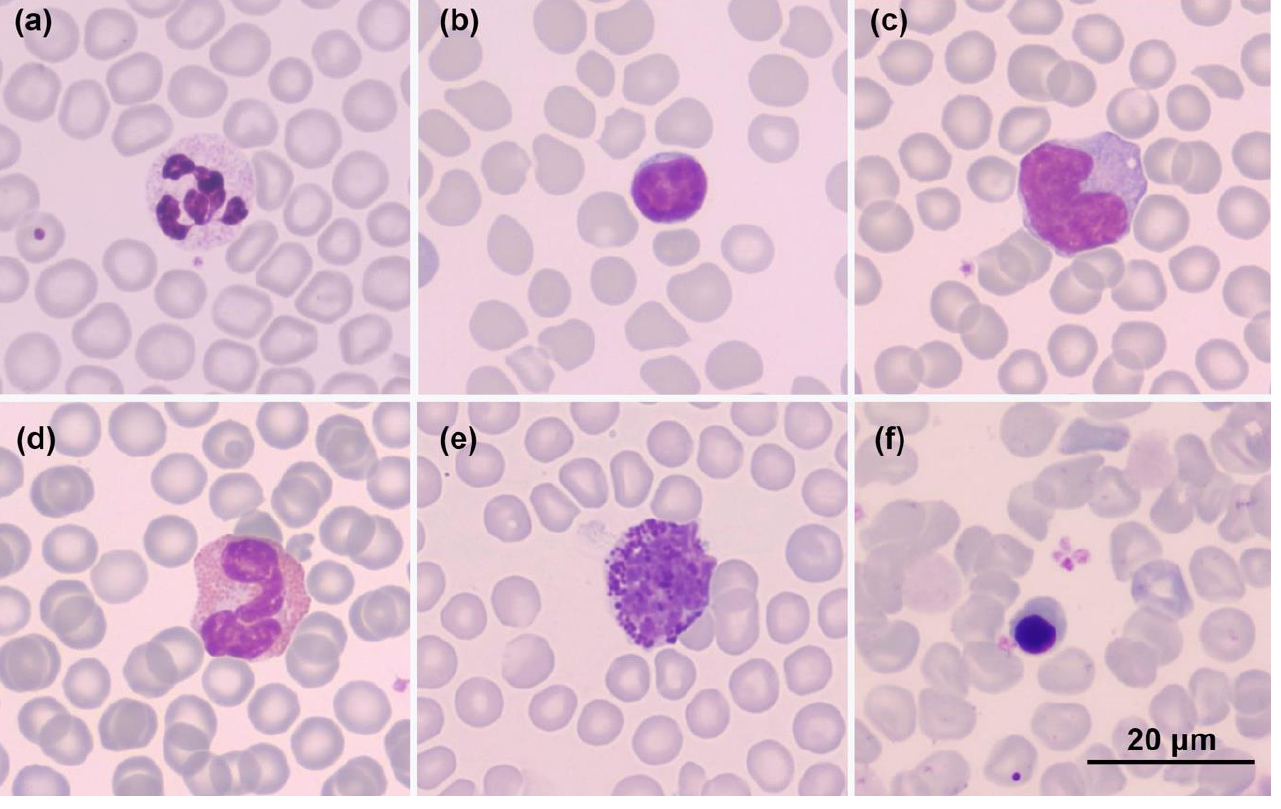
Figure 3. Blood cell morphology (Liu’s stain, x1000 magnification). ( a ) neutrophil; ( b ) lymphocyte; ( c ) monocyte; ( d ) eosinophil; ( e ) basophil; ( f ) nRBC (nucleated red blood cell).